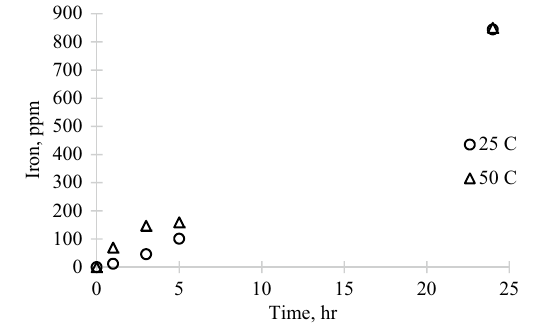
Fig. 7 Concentration of dissolved iron over time in the metal naph- thenate dissolution test at 25 °C and 50